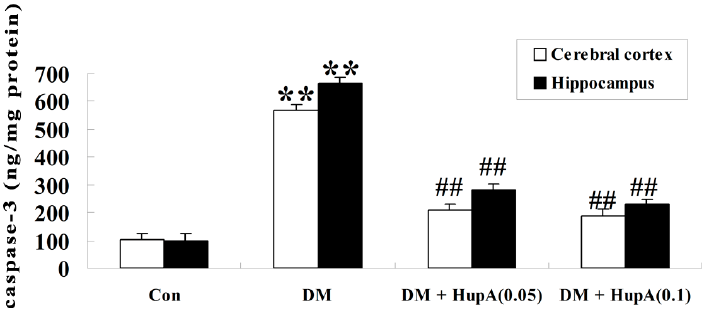
Figure 8. Effects of HupA on the caspase-3 activity in cerebral cortex and hippocampus of control and diabetic rats ( n = 8, mean ± S.D.). ** p < 0.01 compared with Con group; ## p < 0.01 compared with DM group. Con, control; DM, diabetes; DM + HupA